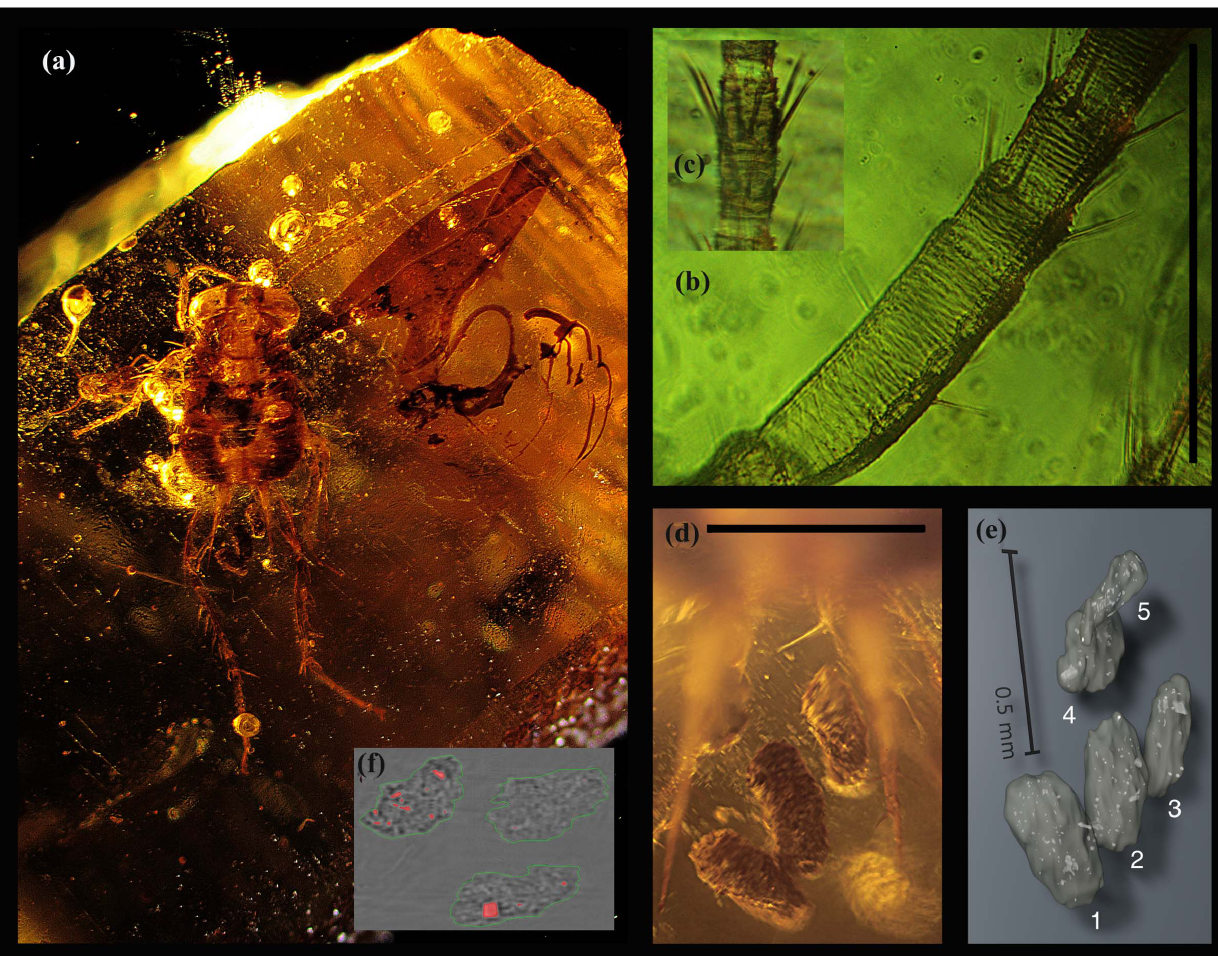
Figure 1. Dinosaur-age cockroach of the extinct family Blattulidae. (A – head to leg end length: 3.8 mm) with antennal sensory system (B, C) and five preserved coprolites (D – optical, E – surface rendering of numbered coprolites and dense particles based on the image stack from synchrotron X-ray microtomography; F – ST orthoslice with labelled boundaries and fragments). Lebanon amber 1094A-I. Scales 0,5 mm.